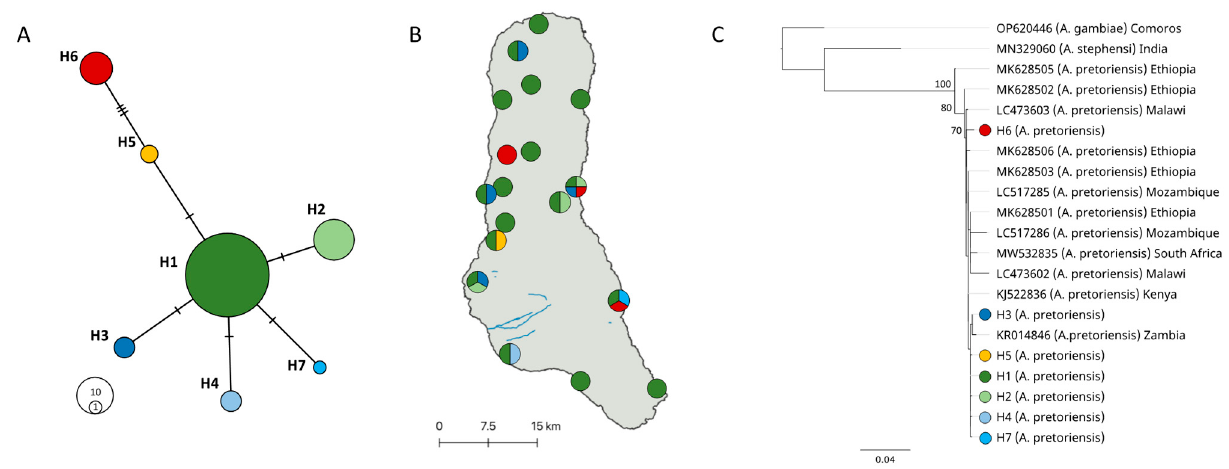
Figure 3. Population genetics of A. pretoriensis in Grande Comore Island. ( A ) Haplotype network of COI sequences from 84 A. pretoriensis specimens collected throughout Grande Comore. Haplotypes were named H1-H7 and color coded. ( B ) Geographic distribution of COI haplotypes; haplotype H1 was present in all but one site. ( C ) Maximum-likelihood phylogenetic tree of the 7 COI haplotypes found in Grande Comore and 12 COI A. pretoriensis sequences from specimens collected from continental Africa. Anopheles gambiae and A. stephensi were included as outgroup species. Branch values indicate supported bootstrap values (>70) .